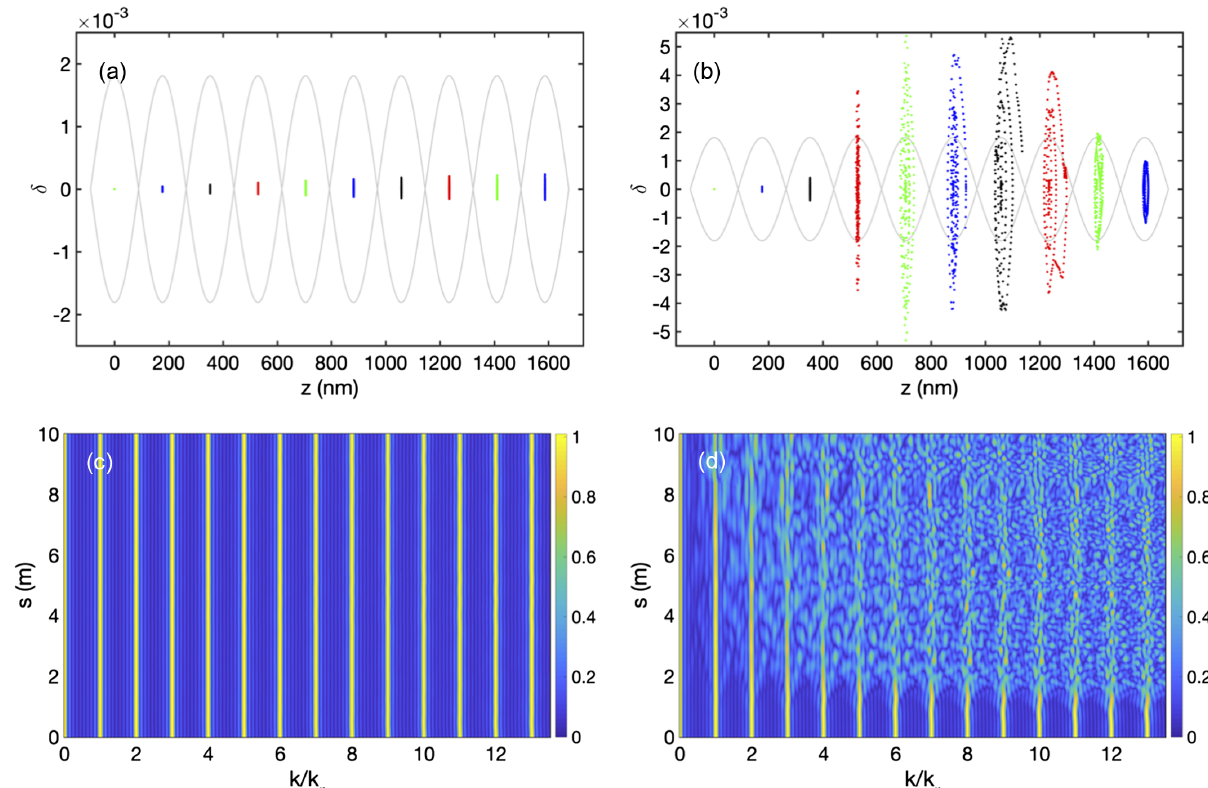
FIG. 11. (a,b) Macroparticle phase space evolution for individual microbunches at s ¼ 10 m with different microbunch charges; (c,d) Evolution of the bunching spectrum along the undulator as a function of the normalized wavenumber. Starting from the n ¼ 0 microbunch, the individual microbunch charges for the left column assume an increasing sequence ð 1 ; 2 ; 3 ; … ; 10 Þ × 1 . 2 × 10 5 , while for the right column a decreasing sequence ð 10 ; 9 ; 8 ; … ; 1 Þ × 1 . 2 × 10 5 . See the context for more